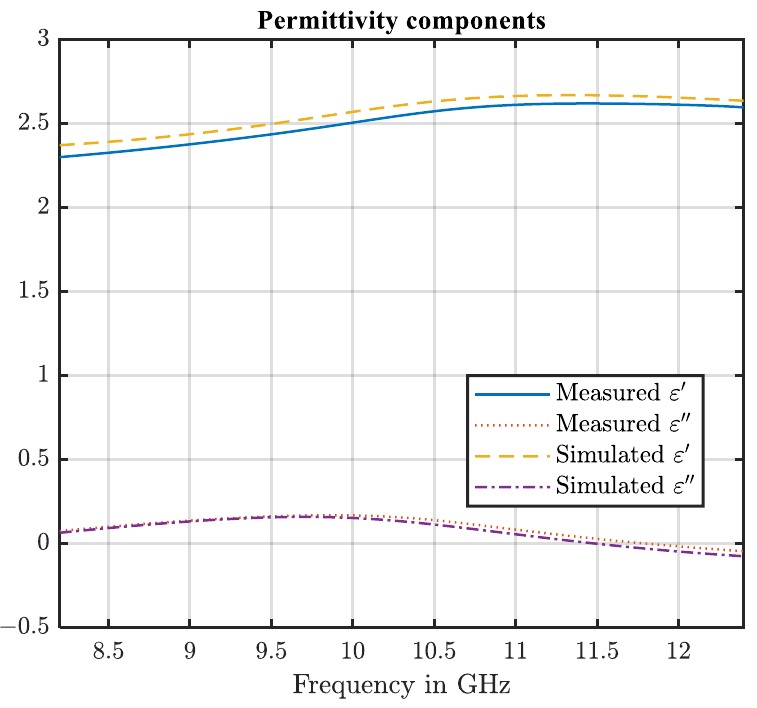
Figure 5. Dielectric constant of MUT obtained by the NIST iterative method.